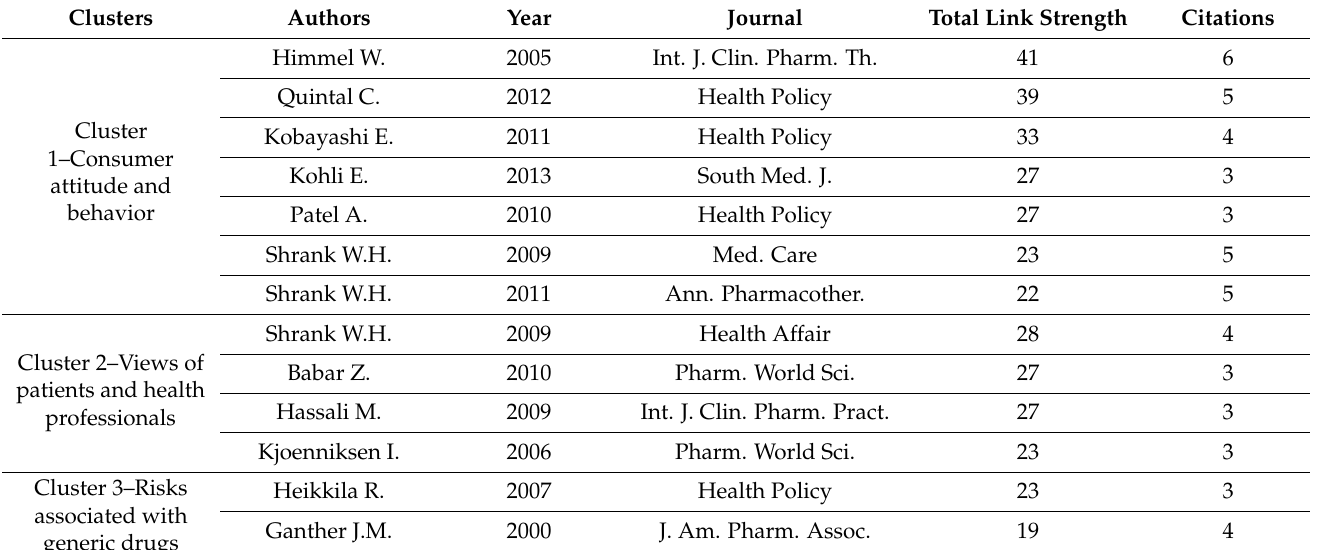
Table 4. Cluster with co-citations of